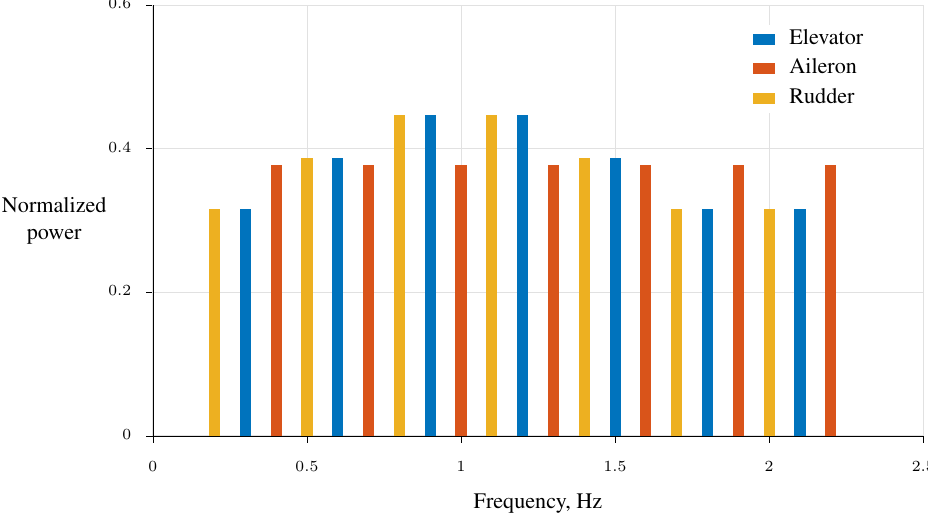
Figure 2. The normalized power spectra design for a multisine set used with the T-2 airplane during AirSTAR flight tests, adapted from ref.